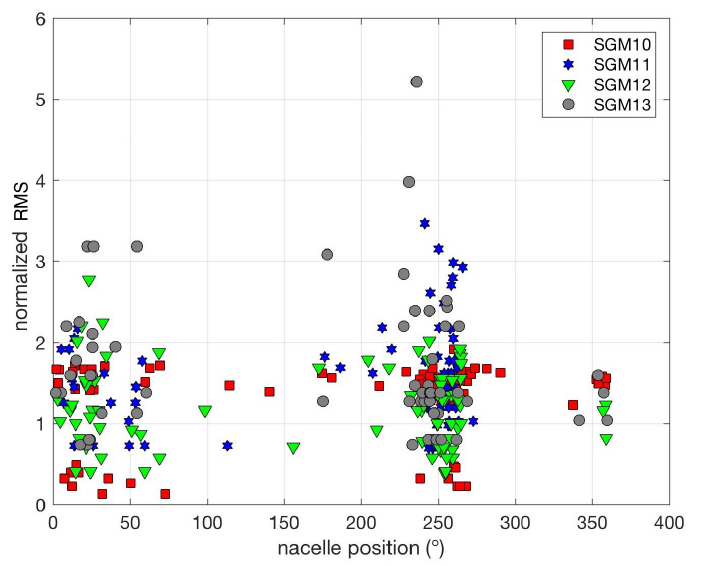
Figure 6. Normalized root mean square of tower vibrations vs. nacelle position (rated